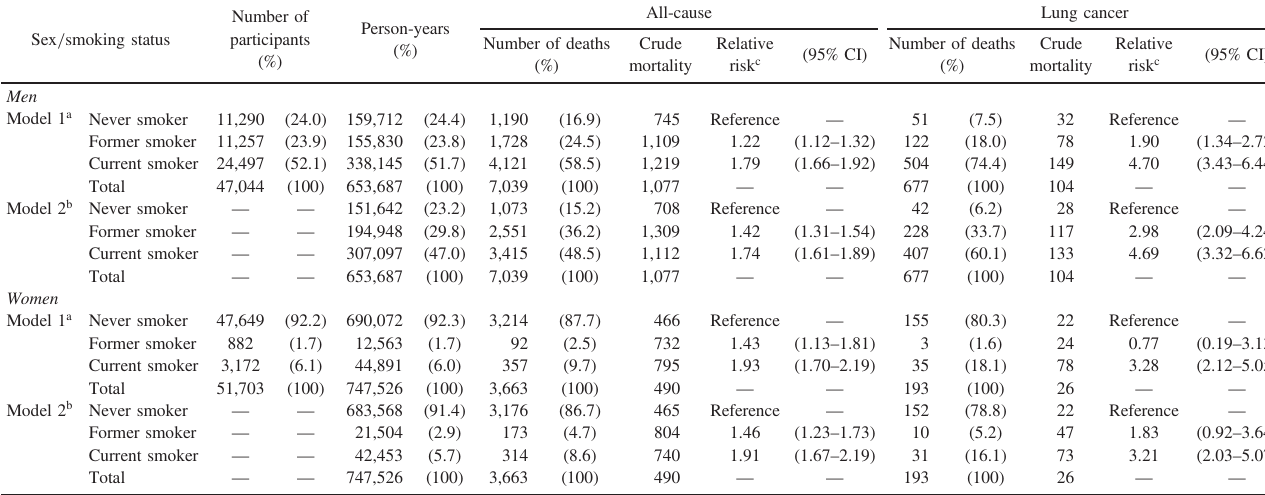
CI, con fi dence interval. a Model 1 used information on smoking status only from baseline.